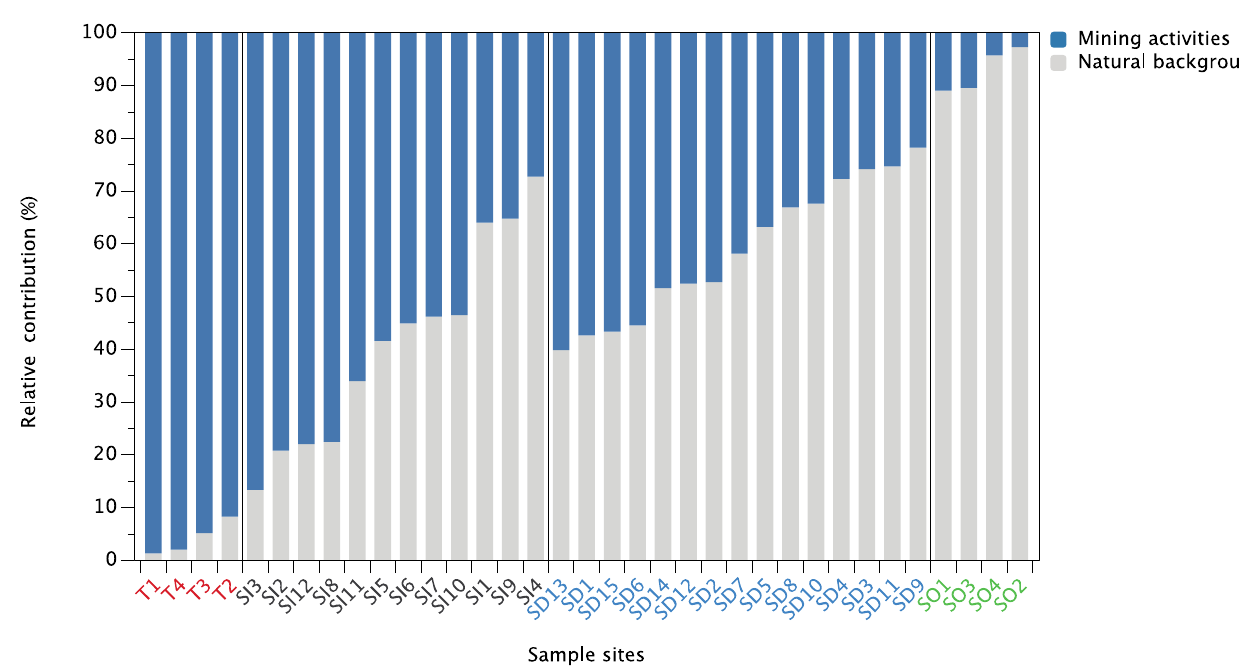
Figure 7. Average relative contribution (%) of Pb from different sources in soils and sediments.